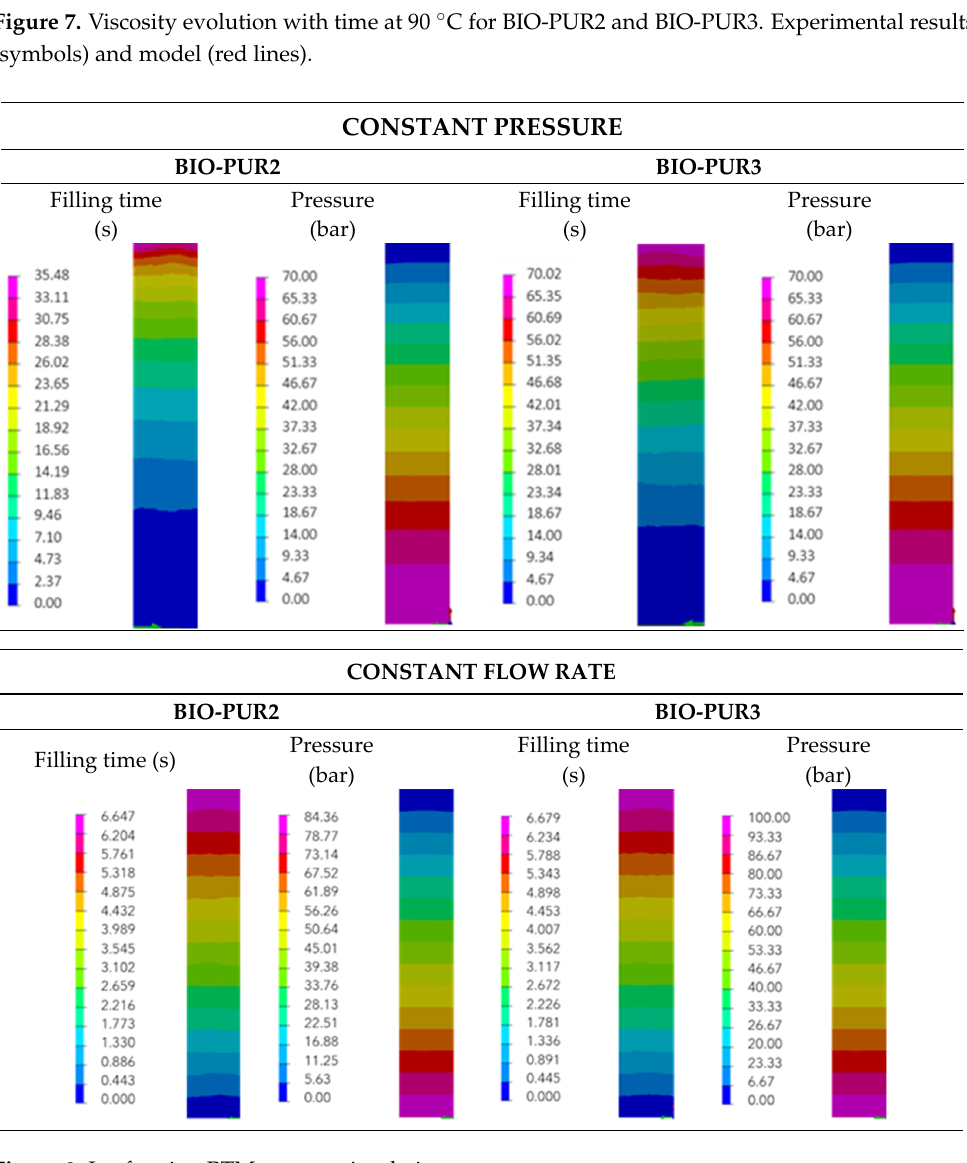
Figure 8. Leaf spring RTM process simulation.